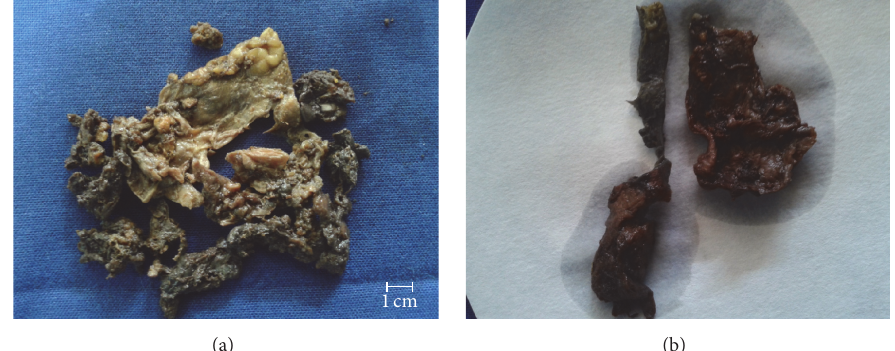
Figure 1: (a) Gross photograph of broad ligament paraganglioma. (b) Gross photograph of paraganglioma with dichromate reaction.